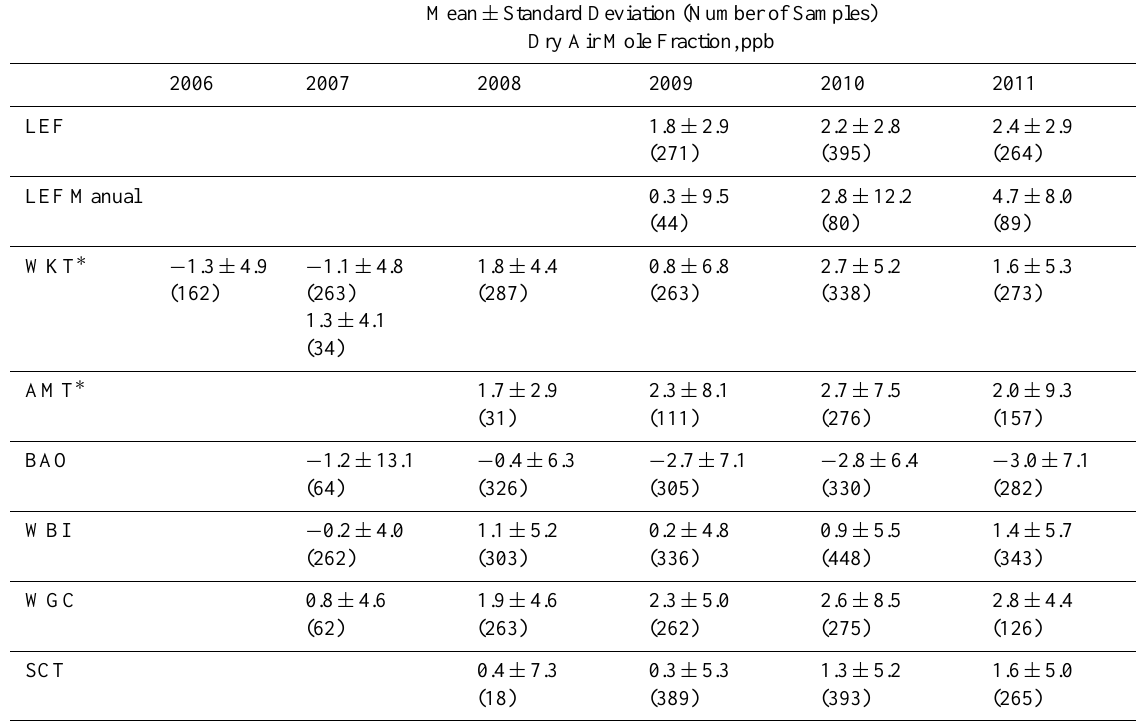
Table 6. Annual summary of flask minus in situ χ CO .